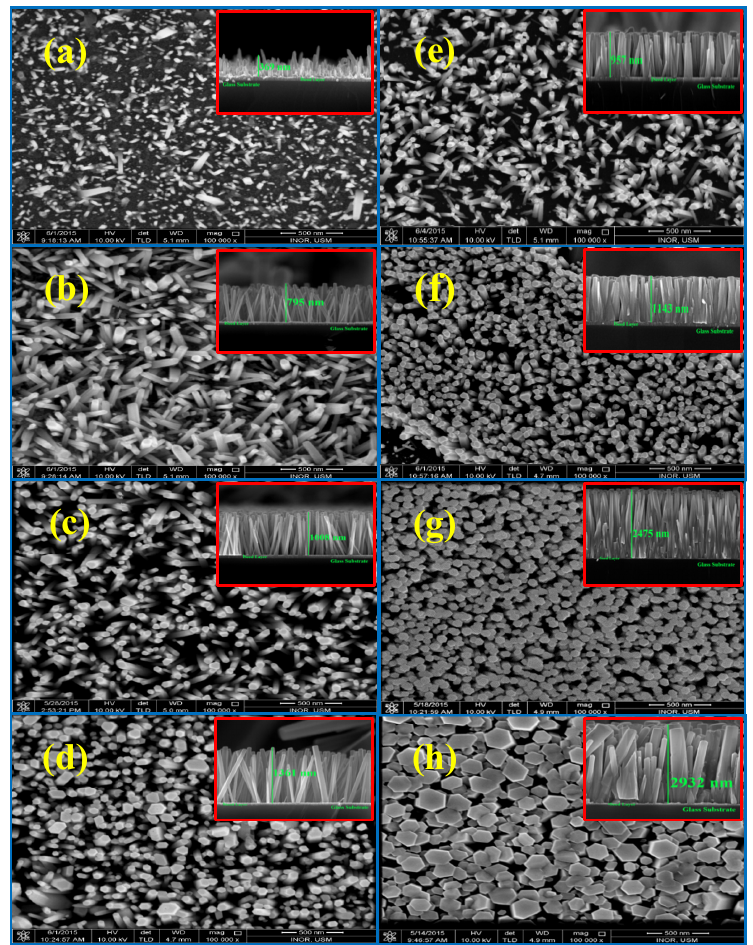
Figure 2. FESEM images of ZnO nanorods grown for different precursor concentrations, no air bubbles: ( a ) 0.01 M, ( b ) 0.025 M, ( c ) 0.05 M & ( d ) 0.075 M and Air Bubble: ( e ) 0.01 M, ( f ) 0.025 M, ( g ). 0.05 M and ( h ) 0.075 M. The insets at the upper right corner represent the cross-section of ZnO nanorods for each concentration representing the cross-section of